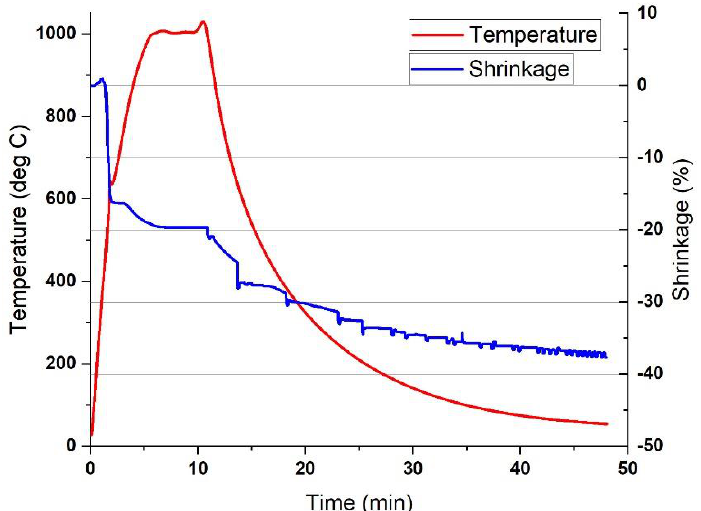
Figure A1. Typical course of temperature and shrinkage during sintering by the PAIS method — specimen 1.